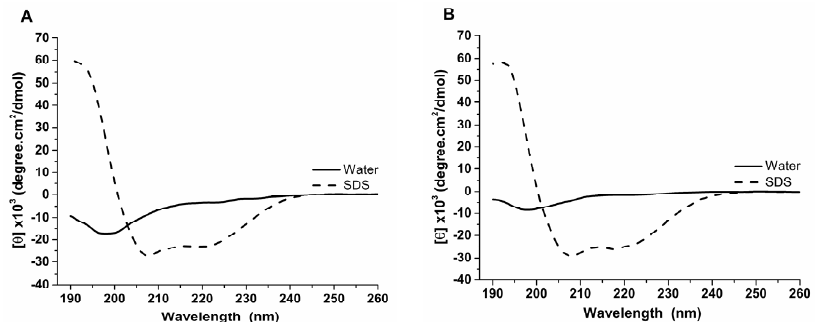
Figure 6. Circular dichroism analysis of the antimicrobial peptides of B. raniceps isolated in the present work. ( A ). Rsp-6 and ( B ). Rsp-3. Dichroic spectra were obtained from 190 to 260 nm, in aqueous solution and in the presence of SDS 35 mM. The thick black lines represent the dichroic curves of the samples in water, whereas the thin and dashed lines represent the dichroic curves in the presence of SDS 35 mM